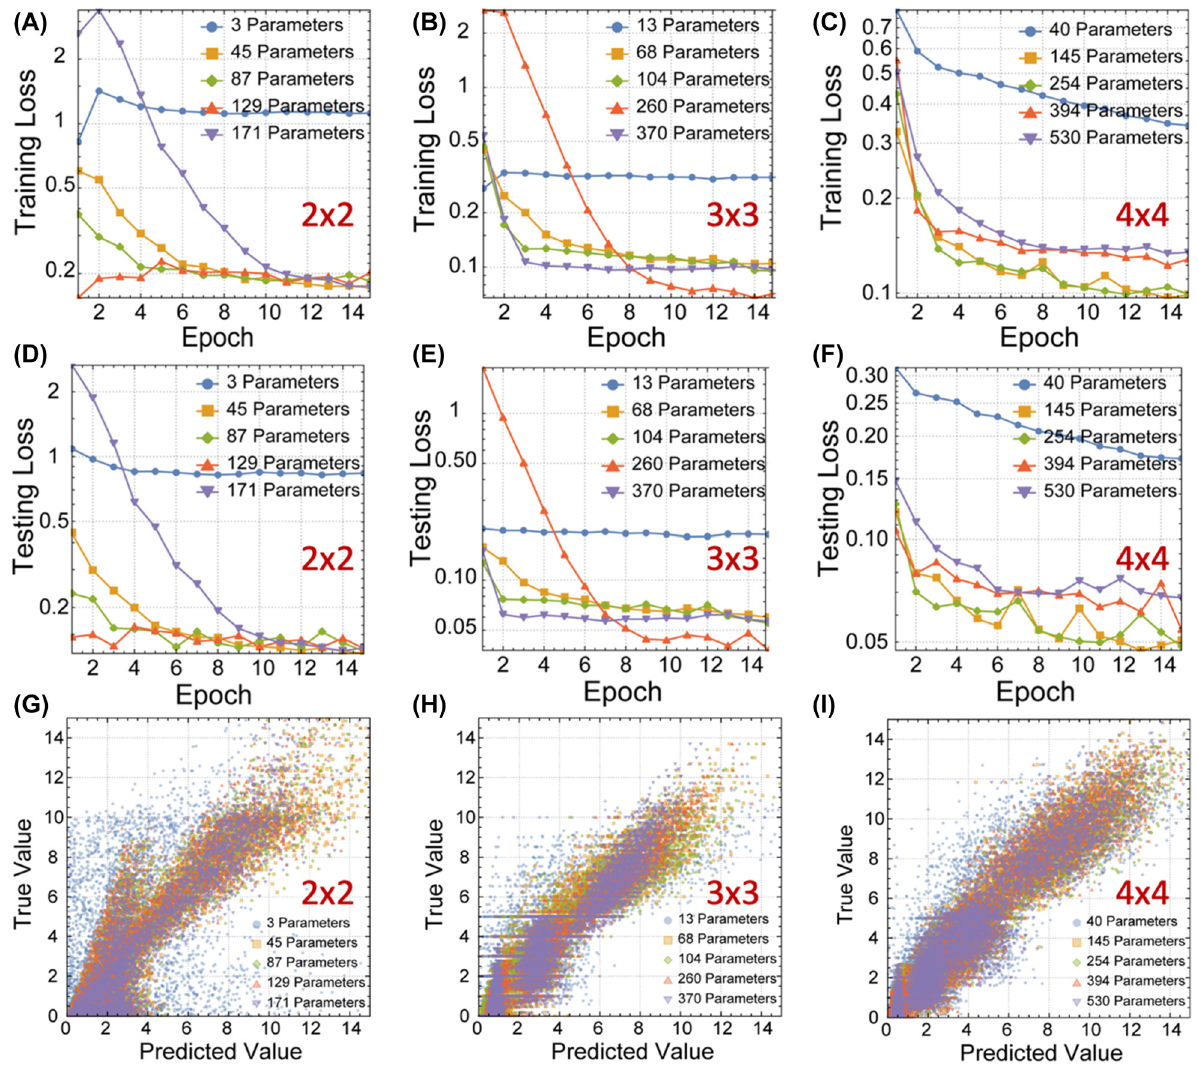
Figure 5: Training and testing results of upscaled eigenvalue solver for 2 × 2, 3 × 3, and 4 × 4 matrices. (A – C) The training loss for 2 × 2, 3 × 3, and 4 × 4 matrices eigenvalue solver for each parameter condition with inserted padded blocks. (D – F) The testing loss for 2 × 2, 3 × 3, and 4 × 4 matrices eigenvalue solver for each parameter condition with inserted padded blocks. (G – I). The correlation diagram of true value and predicted value of 2 × 2, 3 × 3, and 4 × 4 matrices eigenvalue solver for each parameter condition with inserted padded